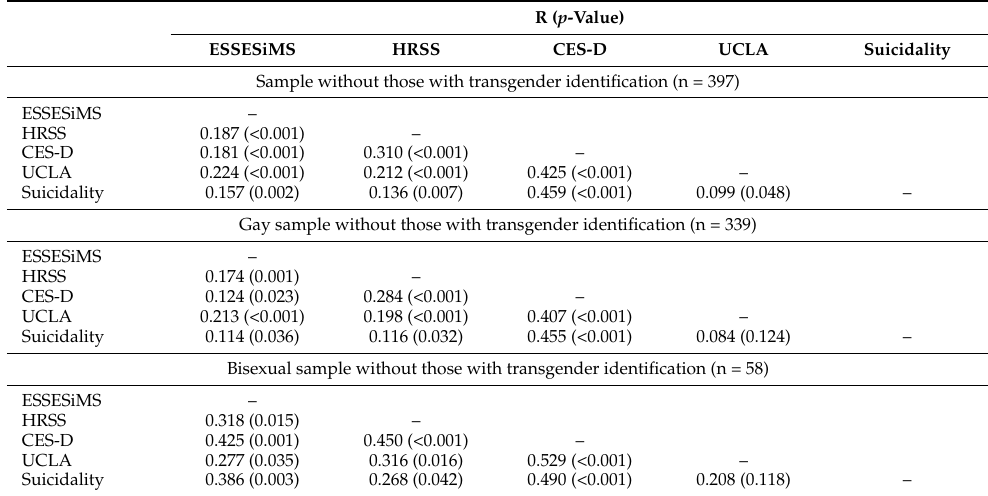
Table 4. Concurrent validity of the Enacted Sexual Stigma Experiences Scale in Military Service